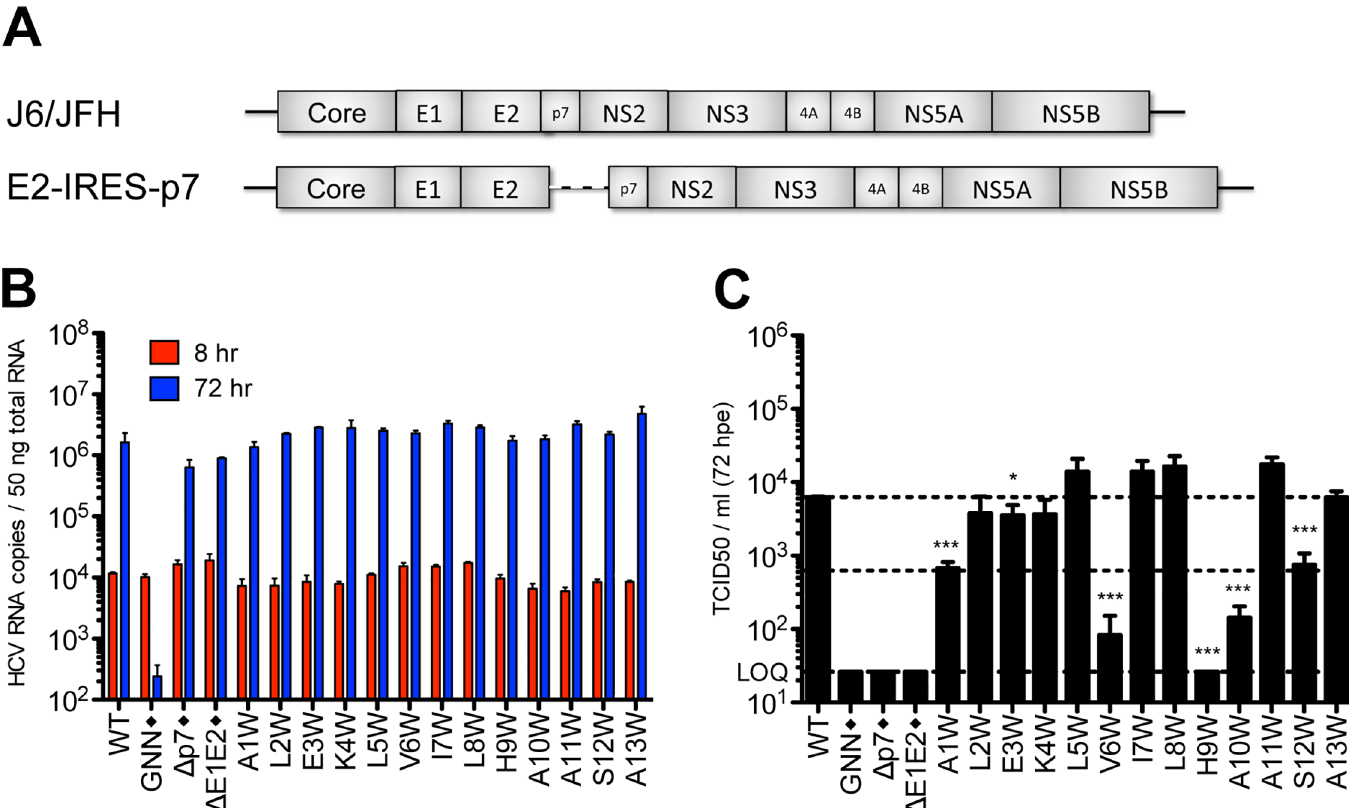
Fig 5. Analysis of N-terminal helix tryptophan substitutions in a bicistronic context. A) Schematic showing the full-length monocistronic and bicistronic (E2-IRES-p7) J6/JFH genomes. B) HCV RNA levels in Huh-7.5 cells 8 and 72 hpe demonstrating that all bicistronic p7 mutants replicate efficiently. C) Infectious virus production quantified by limiting dilution assay on na ï ve Huh-7.5 cells. Mutant viruses yielding significantly less infectious virus as compared with wild-type were identified using unpaired t-tests. Statistical results are indicated as follows: * p < 0.05 and *** p < 0.0001. Dashed lines show the mean wild-type titer (upper line) and a 1 log decrease in titer from wild-type (lower line). Black diamond ( ◆ ) indicates that these control viruses are monocistronic (see GNN, Δ p7, and Δ E1E2 in panels b and c).